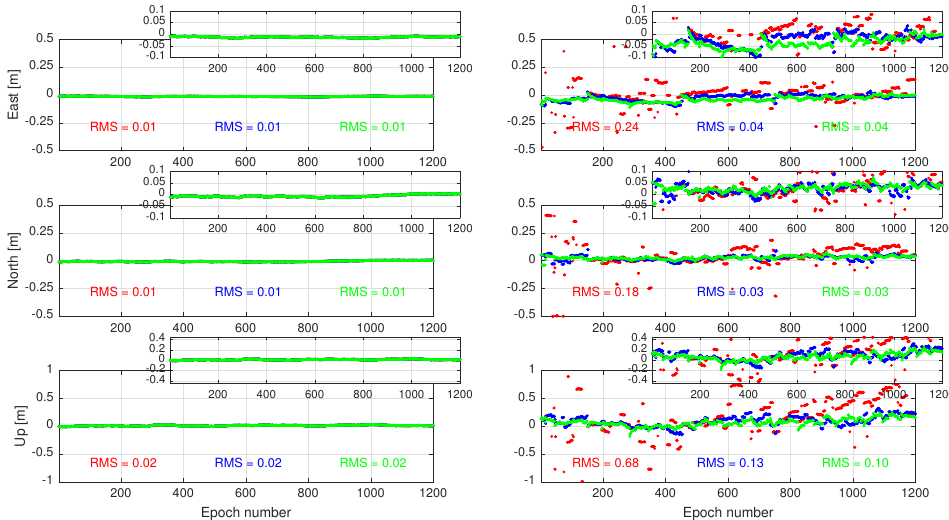
Figure 7. Time-series of the ambiguity-fixed positioning errors in East–North–Up directions when the user experiences no correction latency ( left ) and when the correction packs are provided with a time-delay ( right ). The results of Cases 1, 2, and 3 are indicated in red, blue, and green,